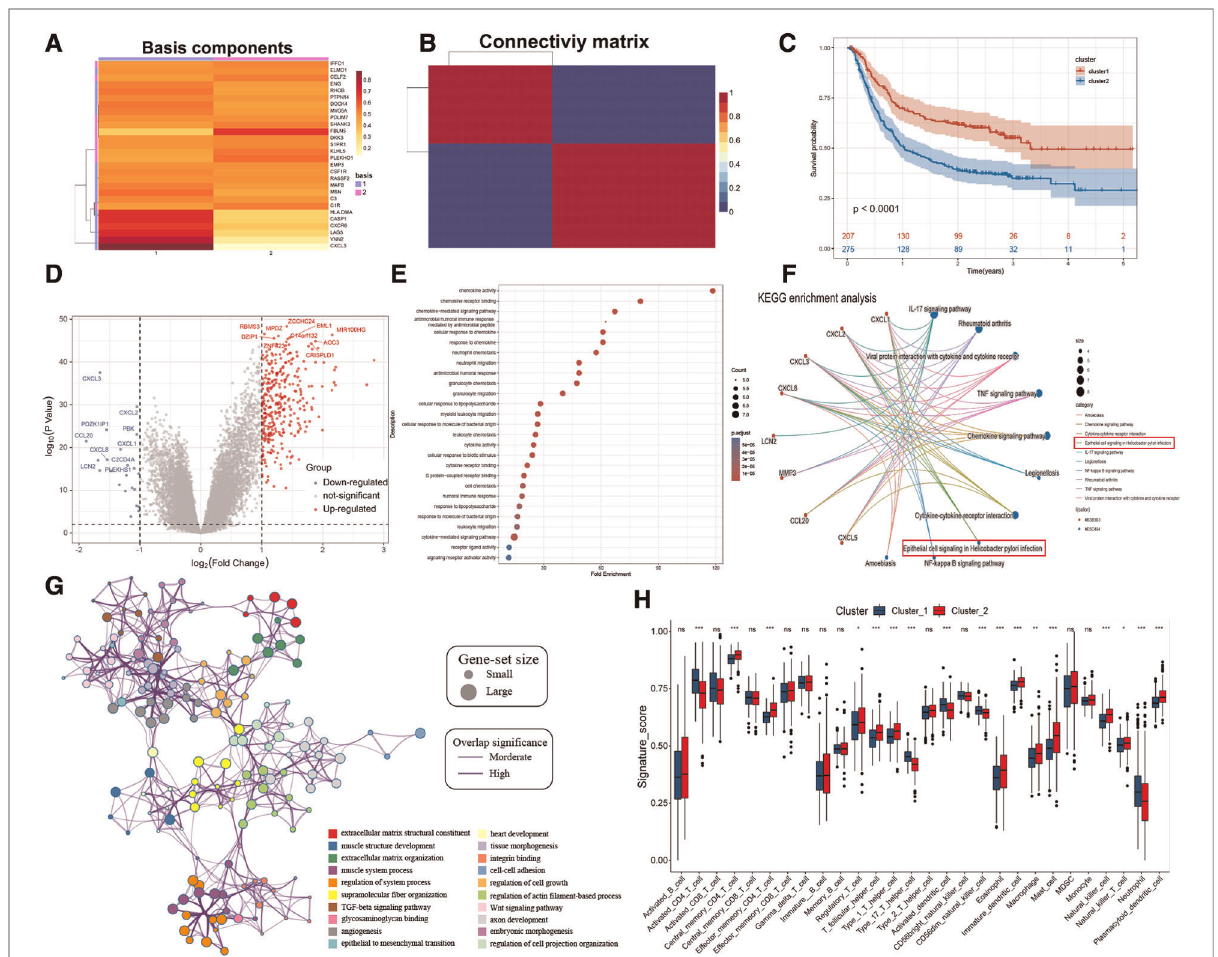
FIGURE 4 NMF for HP-related prognostic genes modi fi cation patterns, biological processes, and immune cell in fi ltration analysis. ( A ) NMF heatmap of basic components of HP-related prognostic genes expression in the two clusters. ( B ) Connectivity matrix for patients with gastric cancer in the meta- dataset by NMF. ( C ) Kaplan-Meier curves showing survival differences between two clusters. ( D ) Volcano plot shows the different genes between cluster 1 and cluster 2. ( E,F ) Bubble plot and gene-concerpt network shows up-regulated genes in cluster 1 involved signaling pathways. ( G ) Cytoscape and enrichment maps are used to visualize the function enrichment analysis results of up-regulated genes in cluster 2 involved signaling pathways. ( H ) Box plot results show differences in the distribution of in fi ltrating immune cells in different